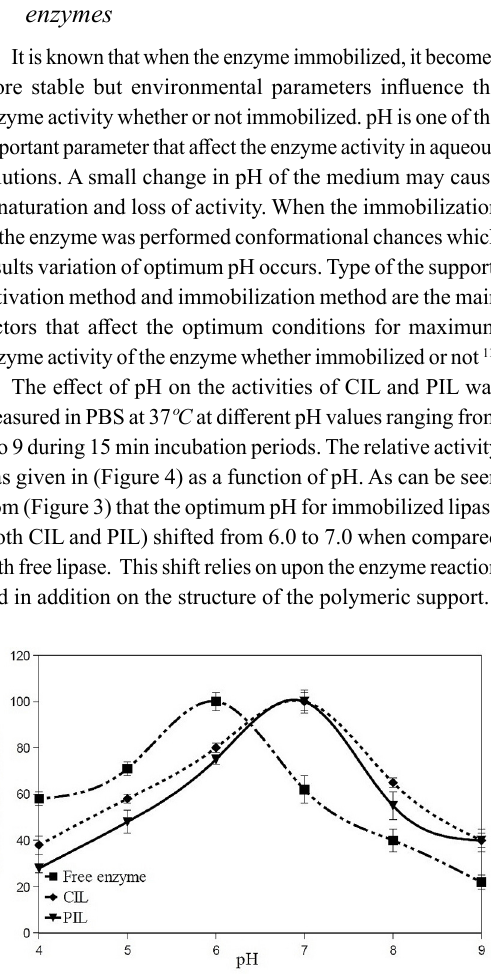
Figure 3: The effect of PH on enzyme